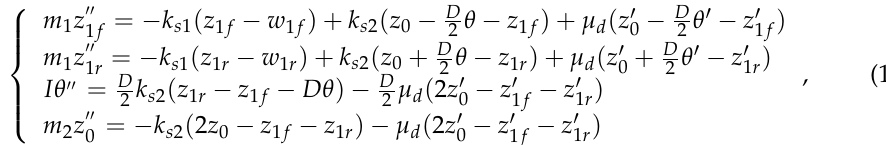
Figure 4. Four degrees of freedom model diagram.